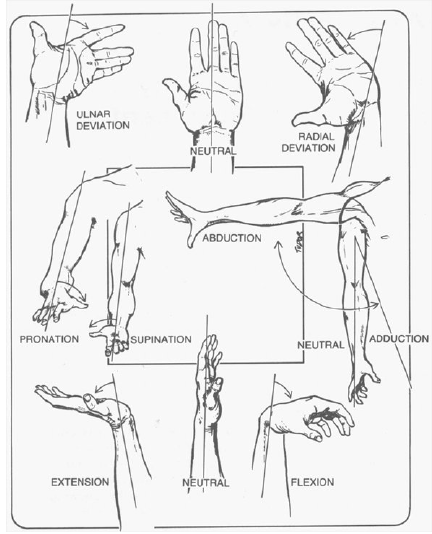
Figure 2. Anatomical terms for motions of upper limb, wrist, and